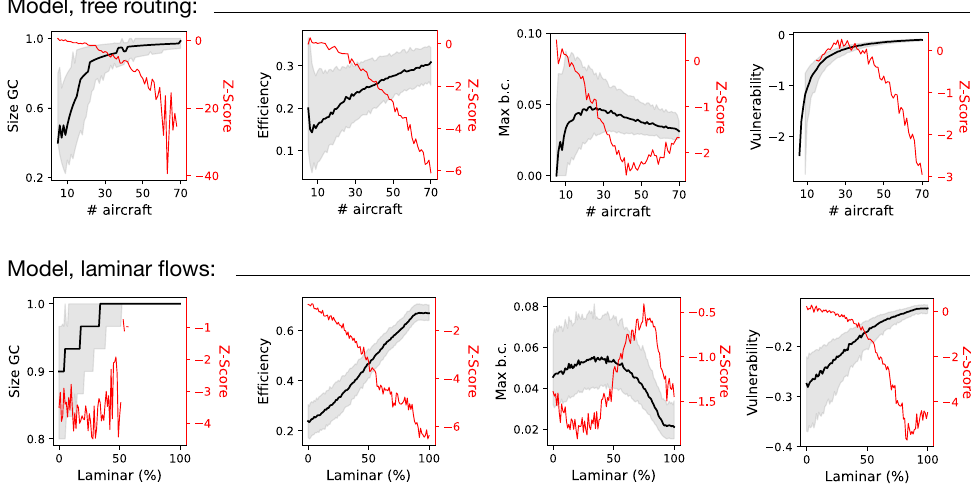
Figure 3. Properties of the interaction networks yielded by the synthetic model, for the free routing ( top panels) and the laminar flow ( bottom panel) cases. See Figures A3 and A4 for full results. Black ( left Y axes) and red lines ( right Y axes), respectively, correspond to the raw values of the metrics and their Z-Scores. Grey bands correspond to the 10–90 percentiles. A radius of interactions ρ = 10 NM was used in the free routing case; N = 30 and ρ = 10 NM in the laminar flows